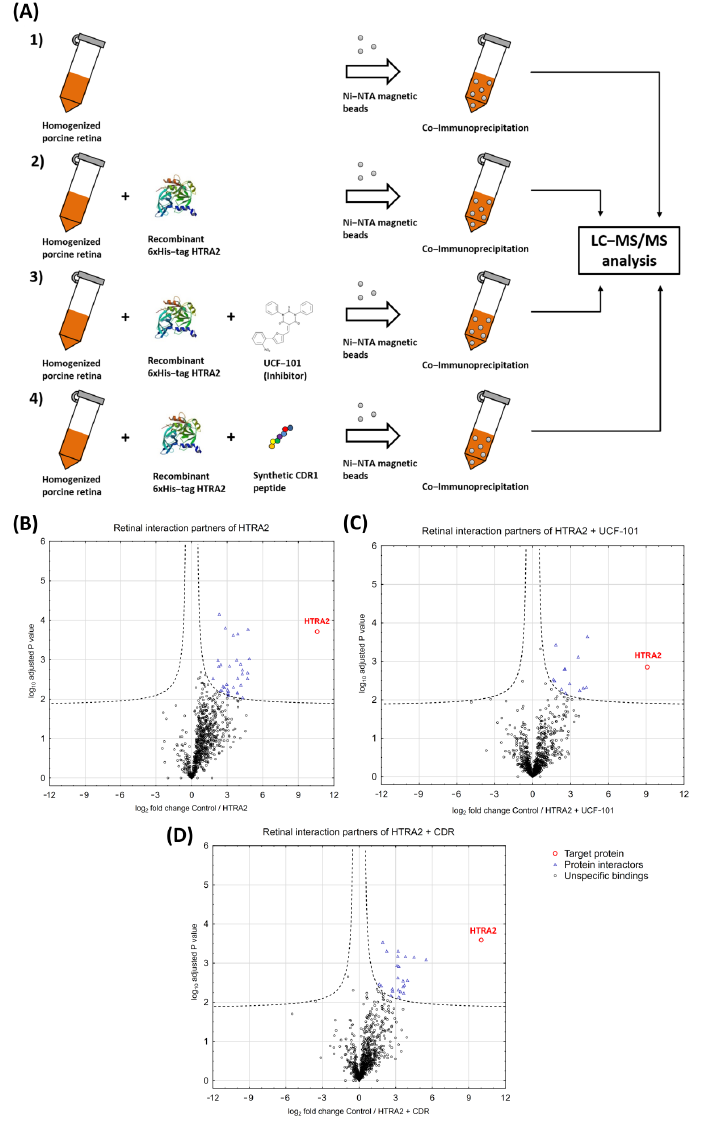
Figure 2. Experimental workflow showing the co-immunoprecipitation of HTRA2-specific protein interaction partners ( A ) from the retinal tissues of house swine ( Sus scrofa ) and ( B – D ) the results of the mass spectrometric data analysis. ( A ) Recombinant HTRA2 (2 µ g) with an N-terminal 6xHis-tag was spiked into 5 mg homogenized porcine retina lysate ± 10 µ g UCF-101 or 10 µ g synthetic CDR peptide ( n = 3 for all of the experimental groups). A control bead group was also included in this experiment to distinguish the HTRA2-specific protein interactors from unspecific binders ( n = 3). Ni-NTA magnetic beads (40 µ L) were added to each sample to enrich recombinant 6xHis-tagged HTRA2 with the respective protein interaction partners. After incubation, all of the bead fractions were extensively washed, and the remaining attached proteins were eluted by pH shift. All of the eluate fractions were further subjected to in-gel trypsin digestion and measured by LC-MS/MS. ( B ) Volcano plot showing the log 2 fold change plotted against -log10-adjusted p values from samples with recombinant 6xHis-tag HTRA2 versus samples from the control bead group ( p < 0.01; log 2 fold change > 1.5); 31 proteins were identified as significant interaction partners of HTRA2. ( C ) Volcano plot analysis revealed 13 significant interaction partners in samples with 6xHis-tag HTRA2 and 10 µ g UCF-101 compared with the control bead group ( p < 0.01; log 2 fold change > 1.5). ( D ) Volcano plot identified 23 significant protein interactors in samples with 6xHis-tag HTRA2 and 10 µ g synthetic CDR peptide compared with the control bead group ( p < 0.01; log 2 fold change >